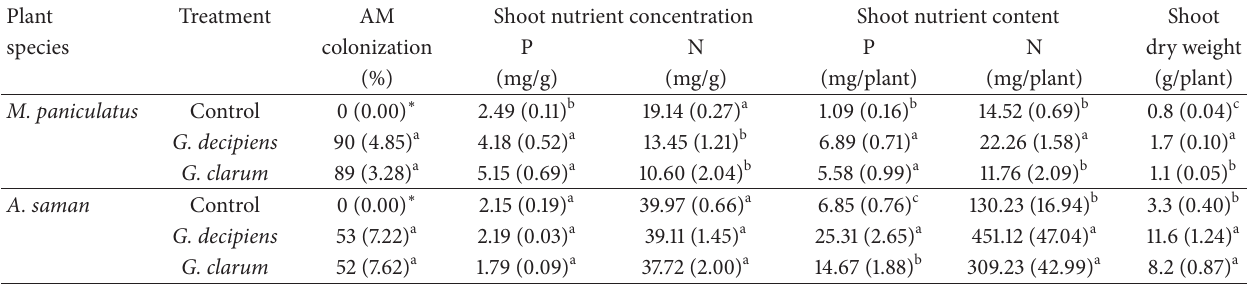
Table 1: Percentage arbuscular mycorrhizal colonization, shoot nutrient concentration, shoot nutrient content, and shoot dry weight of control seedlings or Gigaspora decipiens or Glomus clarum inoculated Mallotus paniculatus and Albizia saman seedlings six months after sowing under nursery conditions in Berau Regency, East Kalimantan,